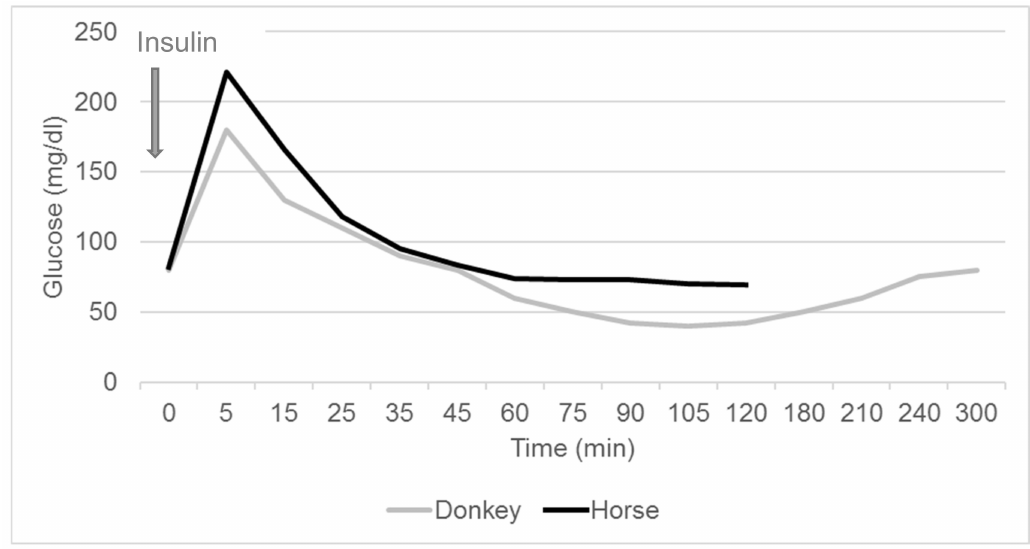
Figure 3. Typical combined glucose insulin test in donkeys compared to